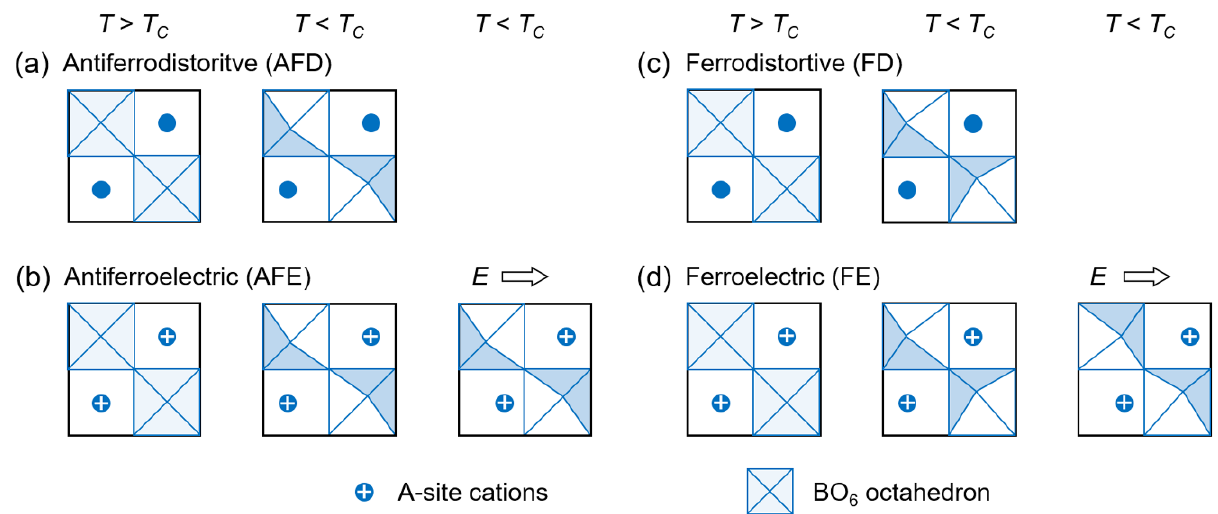
Figure 3. Structural phase transitions of a centrosymmetric perovskite oxide (ABO 3 ). ( a,c ) Antiferrodistortive (AFD) and ferrodistortive (FD) transitions caused by temperature or stress, respectively. Out-of-phase or in-phase octahedral rotation is linked in ( a ) but can be unlinked in ( c ) due to polar distortion. ( b,d ) Antiferroelectric (AFE) and ferroelectric (FE) transitions caused by temperature and electric field E , respectively. Associated with symmetry lowering, polar octahedra in an FD phase may respond to applied electric field together with A-site cations.